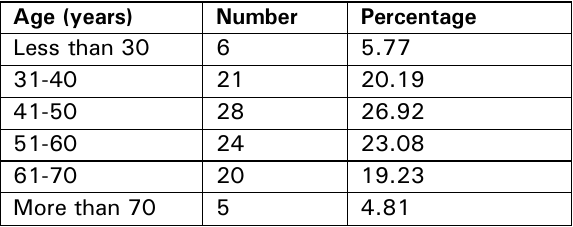
Table 1: Age distribution of the study subjects